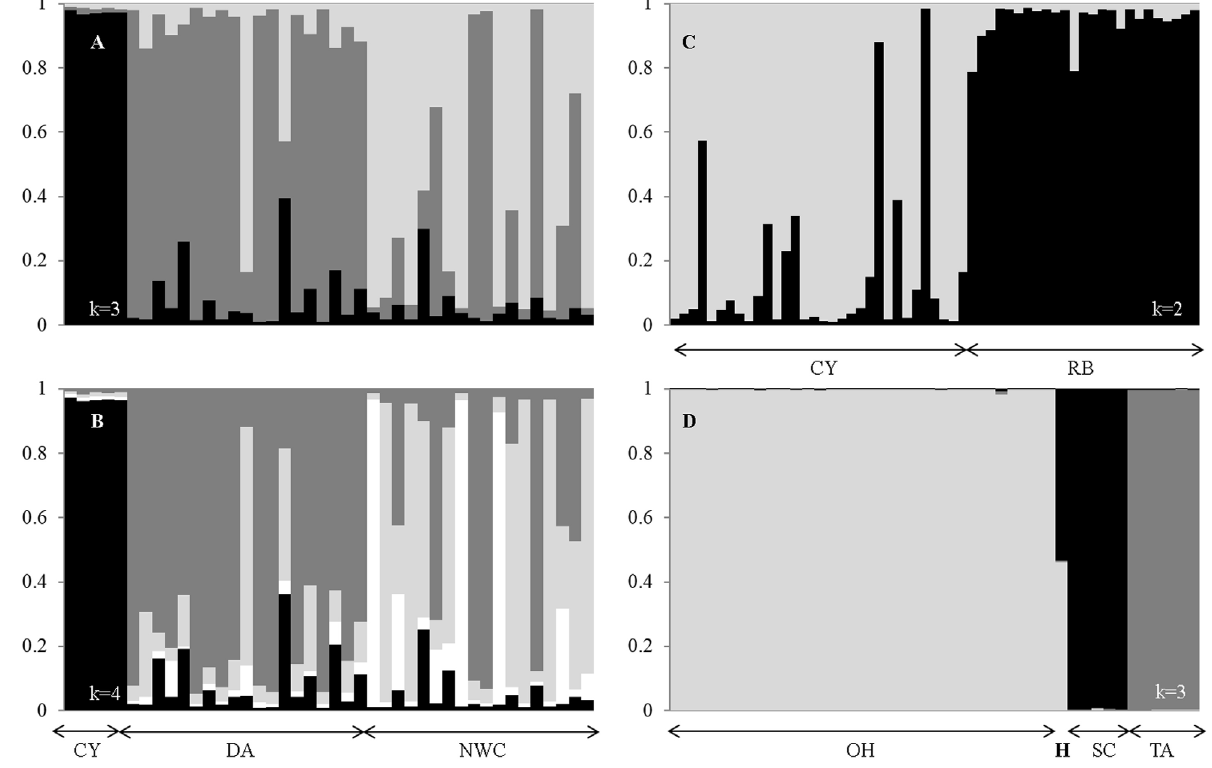
Figure 3. Structure plots for humpback dolphins where k=3 (A) and k=4 (B), for snubfin dolphins (C), and the three regularly encountered dolphin species at Cygnet Bay (D). k=number of clusters. Each bar on the x-axis corresponds to an individual. The y-axis indicates the proportion of population/species membership. OH=snubfin dolphins, SC=humpback dolphins, CY=Cygnet Bay, DA=Dampier Archipelago, NWC=North West Cape, RB=Roebuck Bay, H=suspected hybrid, TA=bottlenose